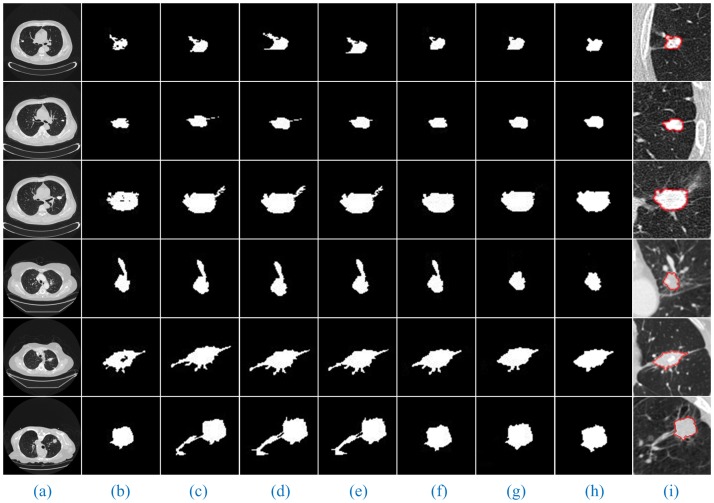
Comparison of the segmentation results of seven methods for juxta-vascular nodules.Column (b) shows the results of the lung nodule image masks using RG (gray threshold of 0.15). The other detailed descriptions are the same as in Fig 12.